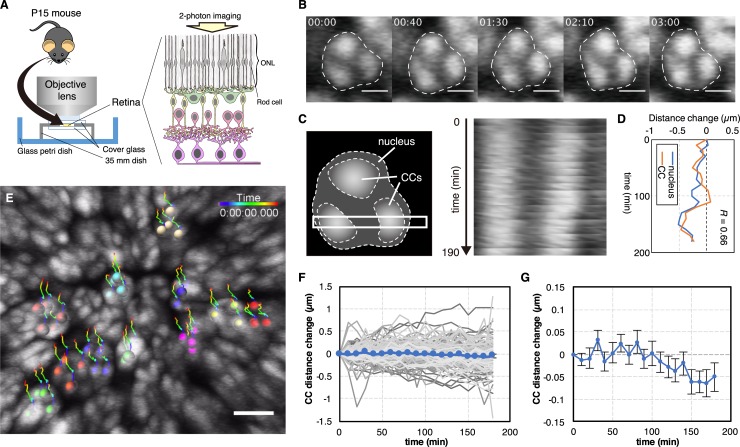
Ex vivo live imaging of chromocenter (CC) clusters in mouse rod cells 15 days after birth (P15).(A) Live imaging system (see the Supplemental Experimental Procedures for details). ONL: outer nuclear layer. (B) Time-lapse single plane images of a single rod-cell nucleus in a P15 mouse. The white dashed lines represent the nuclear edges. Scale bars: 2 μm. (C) Schematic cell nucleus with the ROI (white frame, left panel) used to construct the kymograph (right panel). (D) Correlated change in the nucleus width and distance between CC clusters. Data are derived from the kymograph in panel (C). (E) A representative projected-fluorescence image of the rod-cell nuclei from a P15 mouse (S7 Movie). Center of mass in CC clusters of cells are represented by colored balls. Color-coded lines represent trajectories of CC clusters. Scale bar: 5 μm. (F, G) Dynamics of CC distances within individual nuclei (gray lines) and averaged CC distances (blue lines). Error bars represent SEM. N = 142 from 20 cells.